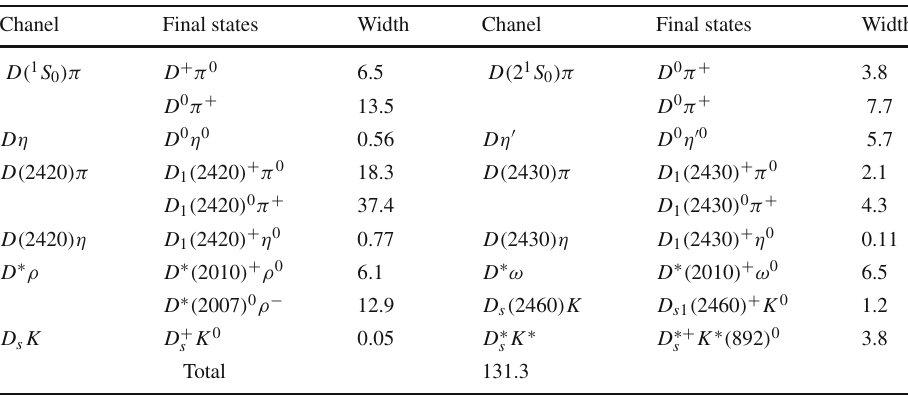
decay widths (MeV) of D